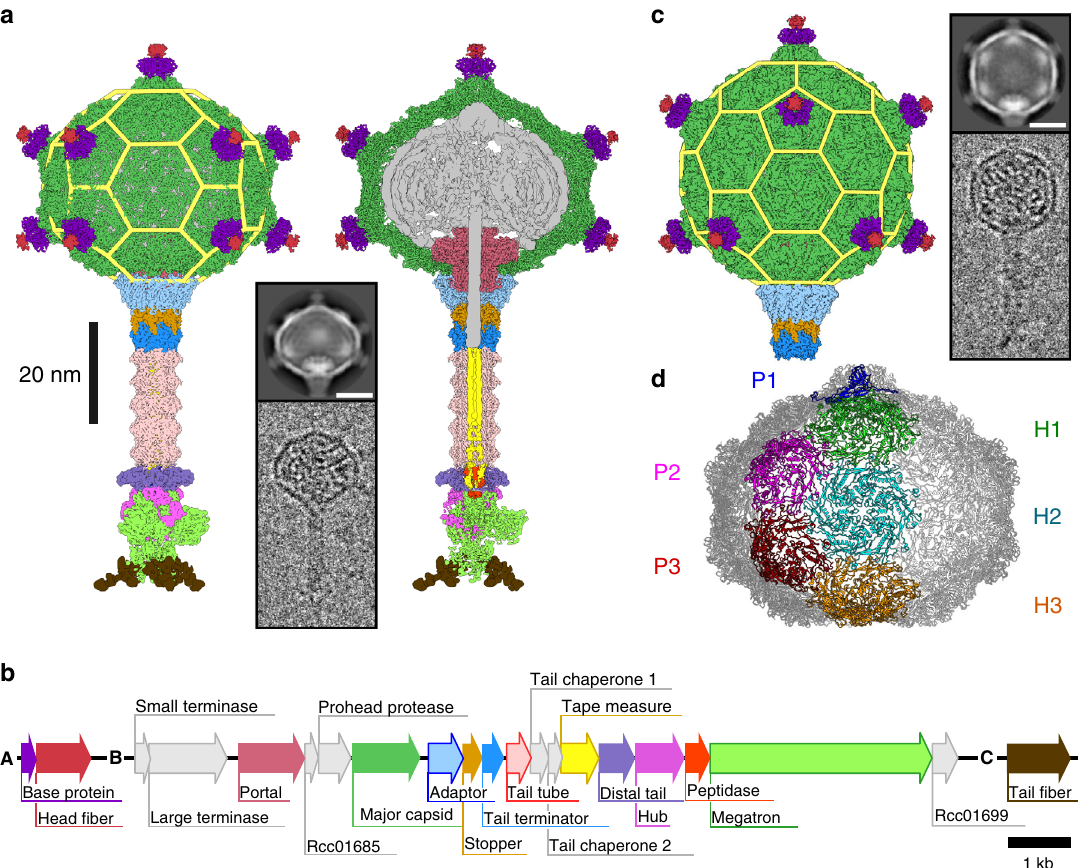
Fig. 1 Structure of the RcGTA particle and organization of segments of the R. capsulatus genome encoding protein components of RcGTA particles. a Cryo-EM reconstruction of a native particle of RcGTA from R. capsulatus strain DE442 calculated from 42,242 particle images. The left part of the panel shows the complete particle, whereas on the right the front half of the particle has been removed to show DNA and internal proteins. Individual proteins in the density map are colored according to the gene map in panel b . Yellow mesh highlights the structural organization of capsid proteins within the RcGTA head. The inset shows an example of a two-dimensional class average and an electron micrograph of an RcGTA particle. The scale bar within the inset represents 20 nm. b Gene map of three genome segments encoding fourteen structural proteins of RcGTA particles. c Cryo-EM reconstruction of an RcGTA particle from R. capsulatus strain DE442 with T = 3 quasi-icosahedral head. The reconstruction is based on 1076 particle images. The structure is at the scale of those shown in panel a . The inset shows an example of a two-dimensional class average and an electron micrograph of RcGTA particle with an icosahedral head. Scale bar represents 20 nm. d Organization of capsomers in the oblate capsid of RcGTA. Capsomers forming one fi fth of the capsid are highlighted in different colors and marked with P for pentamer and H for